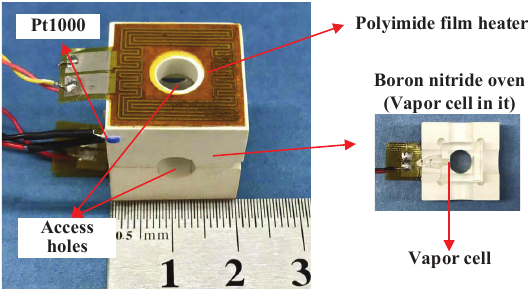
Figure 1. Photograph of the vapor cell and the heating components of an spin-exchange relaxation-free (SERF) atomic